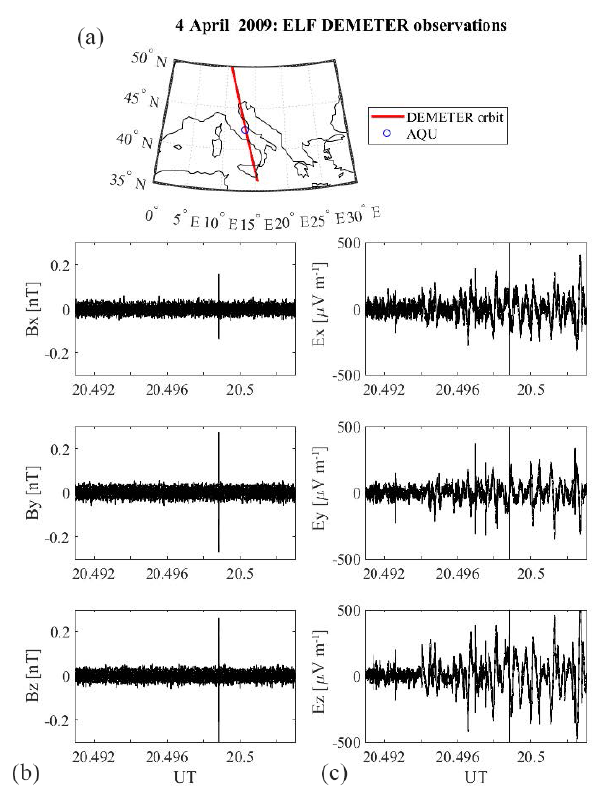
Figure 5. DEMETER electromagnetic observation on 4 April 2009 in the ELF band. (a) shows the satellite orbit (red) as a function of the geographic latitude and longitude. Lower panels show the elec- tric (c) and magnetic (b) field observations as a function of the uni- versal time (UT). The blue circle identifies the L’Aquila geographic